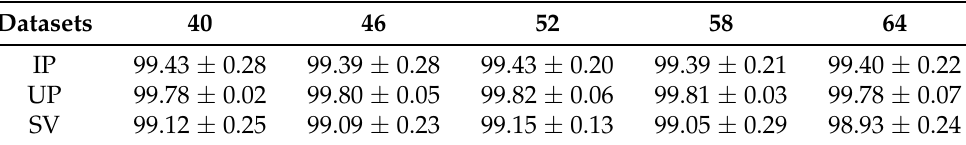
Table 4. OA (%) of PDCNet with different growth rate g in IP, UP, and SV